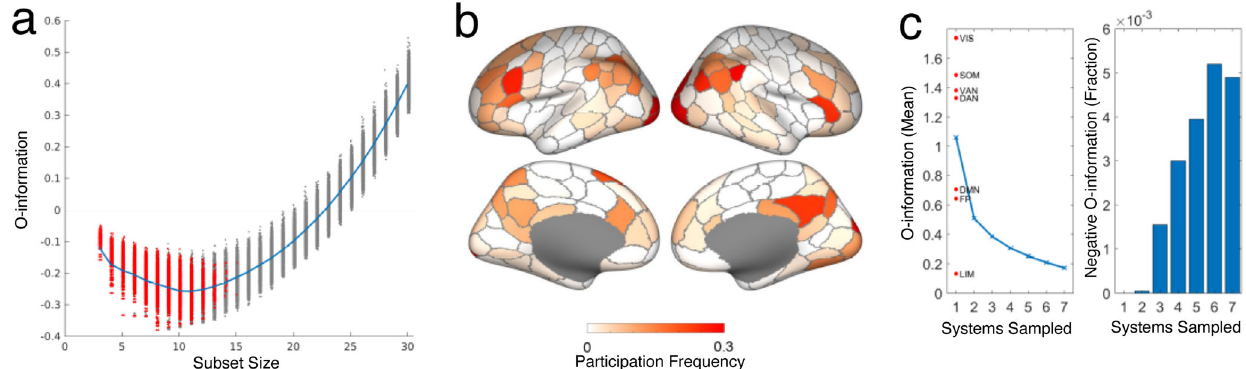
Fig. 5 O-Information, brain topography, and functional specialization of optimally synergistic subsets identi fi ed by simulated annealing All panels show data from the HCP sample. a Annealing was carried out 5000 times for each subset size. This plot shows O-information for each optimized subset (gray dots) and their mean (blue line). Note that annealing fails to converge onto any synergistic subsets for subsets containing more than 24 nodes. Optimally negative O-information is achieved for subsets between 8 and 12 nodes. For each subset of size k each node was removed individually and the O-information of the remaining k − 1 nodes was calculated. If the O-information was lower than given by the original k node subset, the contribution of that node was considered redundant and the synergy in the subset attributable to its k − 1 node counterpart. For the vast majority of subsets smaller than 12 nodes, no nodes could be removed in a way that increased synergy, indicating that these subsets consisted of nodes with irreducible synergy (red in Fig. 5a). b Frequency of individual node participation across optimally synergistic 10-node subsets (4021 unique subsets out of 5,000 annealing runs), displayed on a surface rendering of the cerebral cortex (cf. Fig. 4b). c Mean O-information (left) and fraction of synergistic subsets (right) encountered in samples of 20,000 subsets that contained nodes belonging to between 1 and 7 canonical FC systems (HCP data). The mean O-information for samples obtained exclusively from each of the 7 FC systems is indicated (red